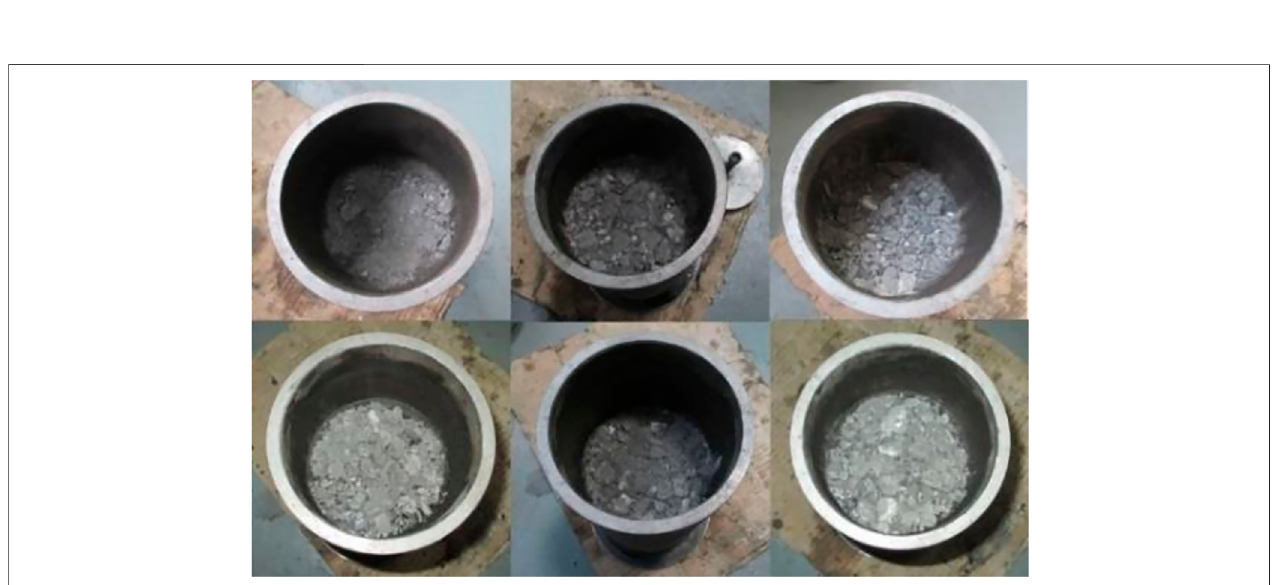
FIGURE 4 | Compaction effect of the specimen.